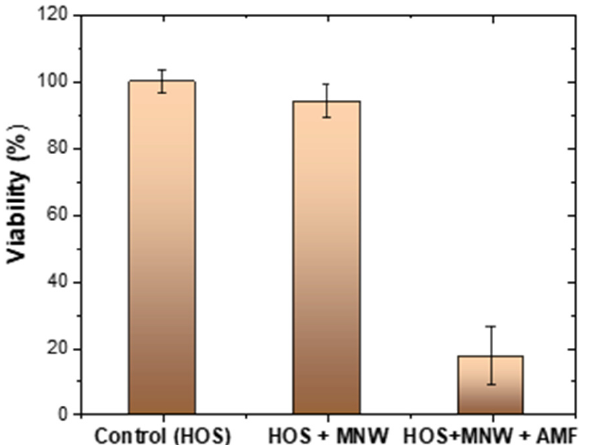
Figure 7. Viability of human osteosarcoma cells incubated with nanowires, in alternating magnetic field (AMF).